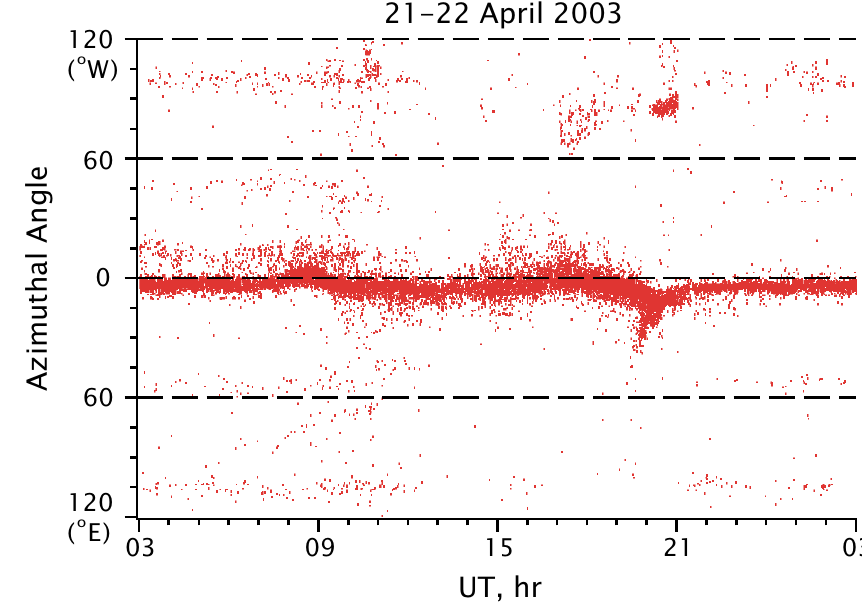
Fig. 3. Azimuth-time plot of incident rays on 21–22 April 2003.